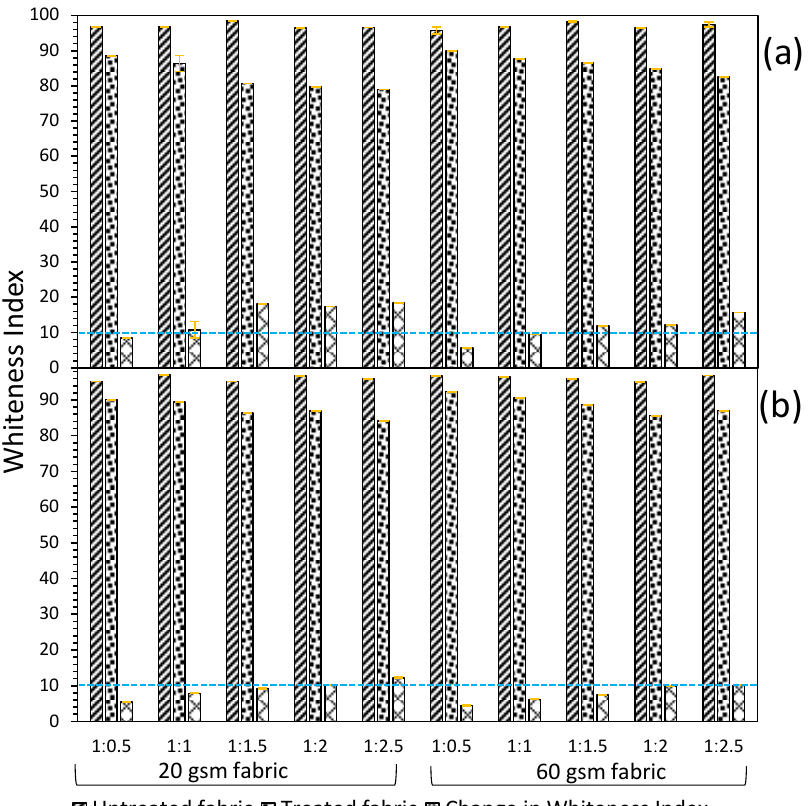
Figure 7. Whiteness Index for ( a ) Nano-emulsion 1 (Moringa oleifera); ( b ) Nano-emulsion 2 (Aegle marmelos) both 20 and 60 gsm organic cotton (dotted blue line indicates 10% Whiteness Index that is noticeable) — padding method.